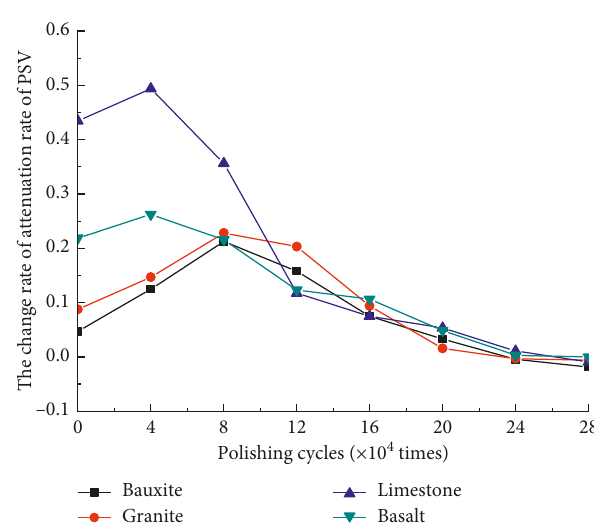
Figure 3: Second-order differential PSV